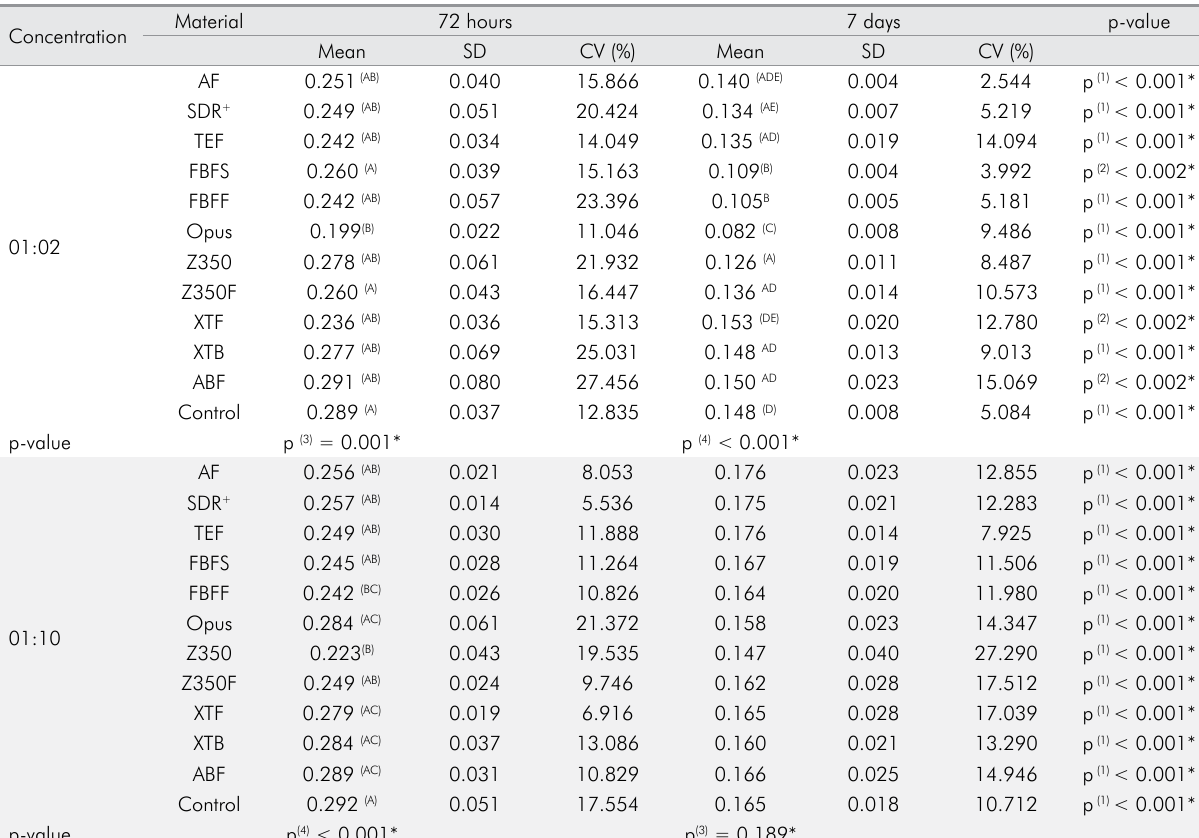
Table 2. Mean ± standard deviation of MTT according to material, concentration, and days of evaluation. Concentration